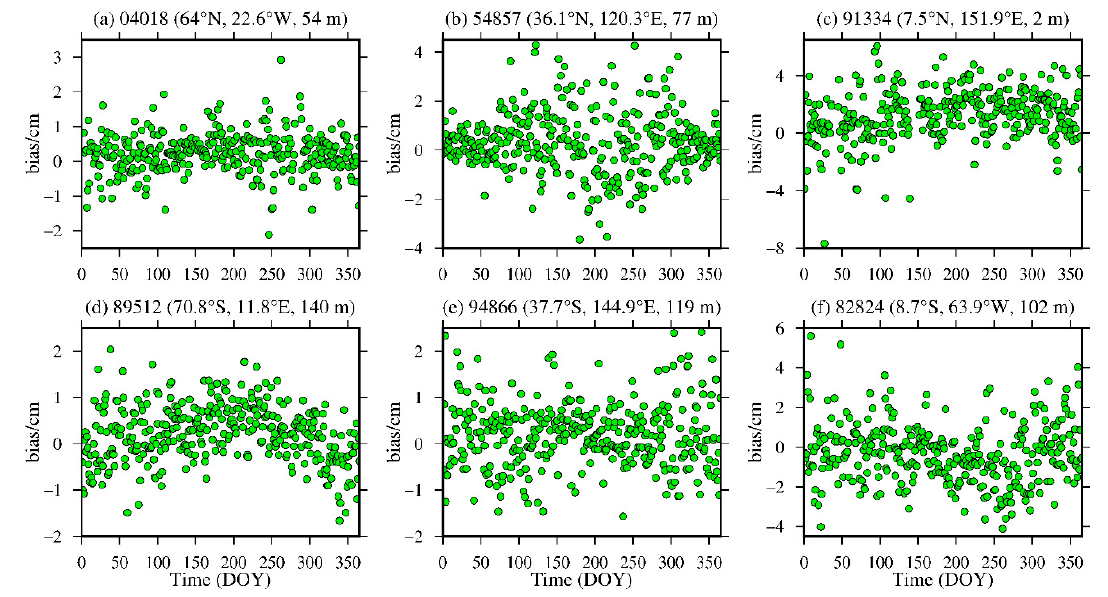
Figure 11. ZTD bias time series of stations ( a ) 04018, ( b ) 54857, ( c ) 91334, ( d ) 89512, ( e ) 94866 and ( f ) 82824 derived from the MERRA-2 data from 2015 (the content in parentheses indicates the latitude, longitude and altitude of the radiosonde station).